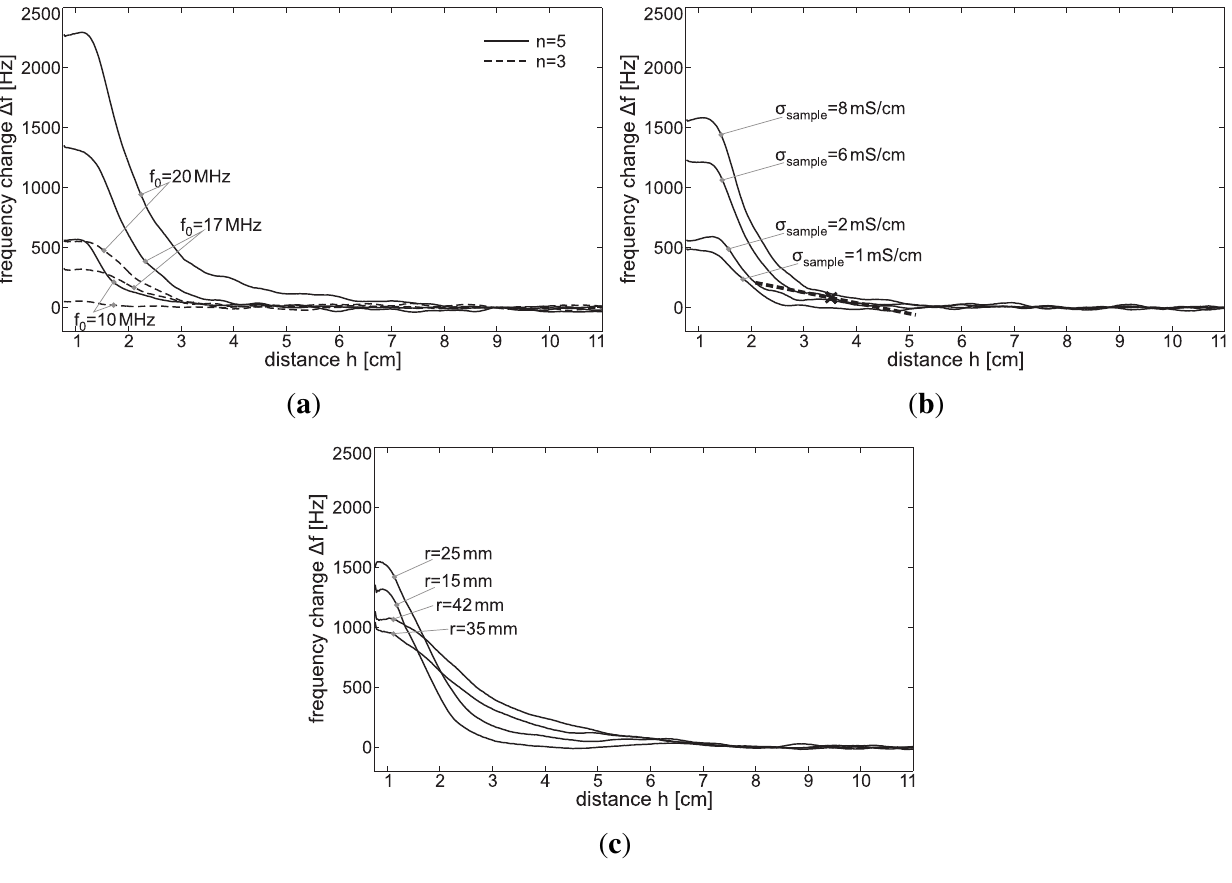
, and numbers of windings, n . 0